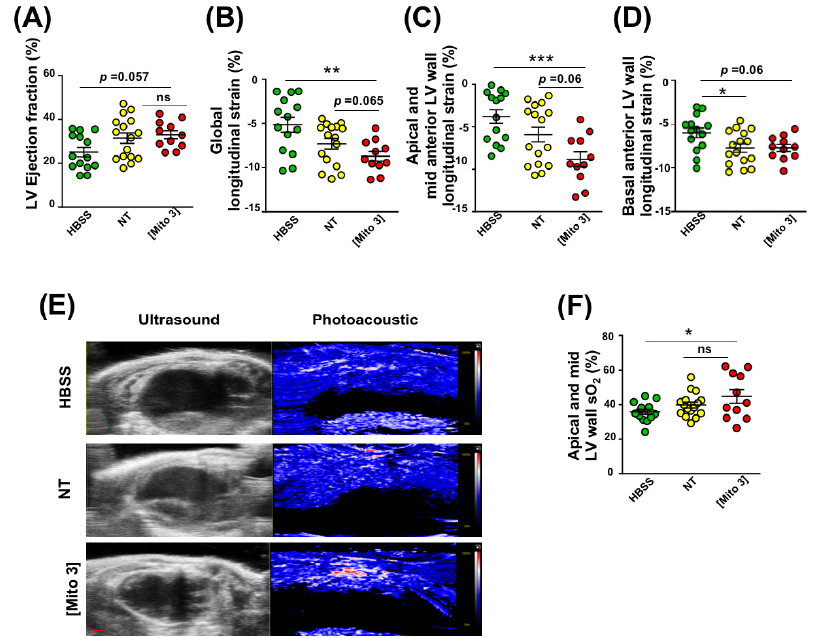
Figure 7. Cardiac mitochondria transfer enhances cardiac function and myocardial perfusion 21 days after myocardial infarction. ( A – D ) MSCs were conditioned with cardiac mitochondria (Mito3 concentration) 24 h prior to engraftment in infarcted mouse hearts. Different cardiac functional parameters were evaluated in infarcted mice treated with a saline solution (HBSS), non ‐ treated MSCs (NT), or cardiac mitochondria ‐ preconditioned MSCs (Mito 3) at day 21 post ‐ surgery and graft. ( A ) LV ejection fraction; ( B ) global longitudinal strain; ( C ) apical and mid anterior LV wall longitudinal strain; ( D ) basal anterior LV wall longitudinal strain. ( E ) Representative B ‐ mode ultrasound parasternal long ‐ axis view to define the left ventricular anterior wall and photoacoustic mode with color scaling to show areas of high oxygen saturation in red and low oxygen saturation in blue in hearts from the different mouse treatment groups. Scale bar: 1 mm. ( E ) Variation of myocardial anterior wall sO 2 in the different mouse treatment groups. One ‐ way ANOVA with Tukey’s multiple comparisons test in ( A – D , F ). * p < 0.05, ** p < 0.01, *** p < 0.001. Each dot represents a mouse. Infarcted mice treated with a saline solution (HBSS) ( n = 11), non ‐ treated MSCs (NT) ( n = 11), or cardiac mitochondria ‐ preconditioned MSCs ( n = 10). Bar graphs represent mean values ± SEM.